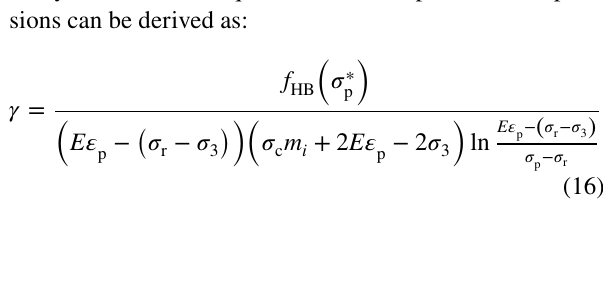
Table 3 Constitutive model parameter value under different temperature confining pressure conditions